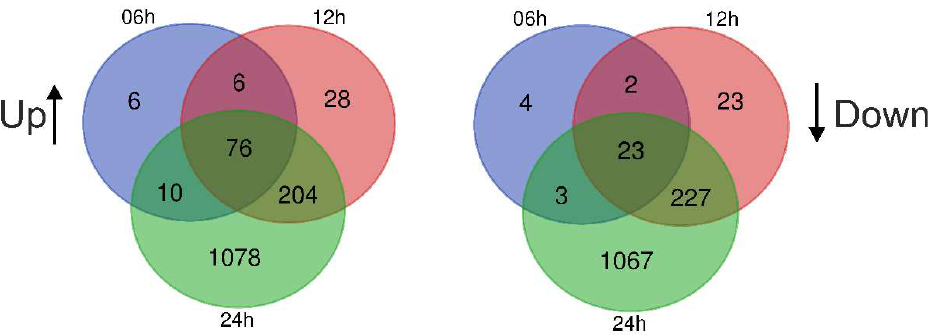
Figure 3. Venn diagrams showing intersections of differentially expressed genes in A549 cells that were incubated with human blood EVs for 6, 12, and 24 h. Up and Down—up- and downregulated genes.